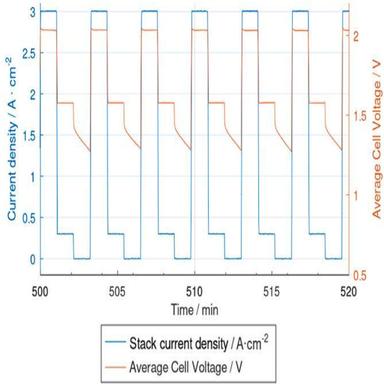
Section of an AST protocol performed for an electrolysis stack.